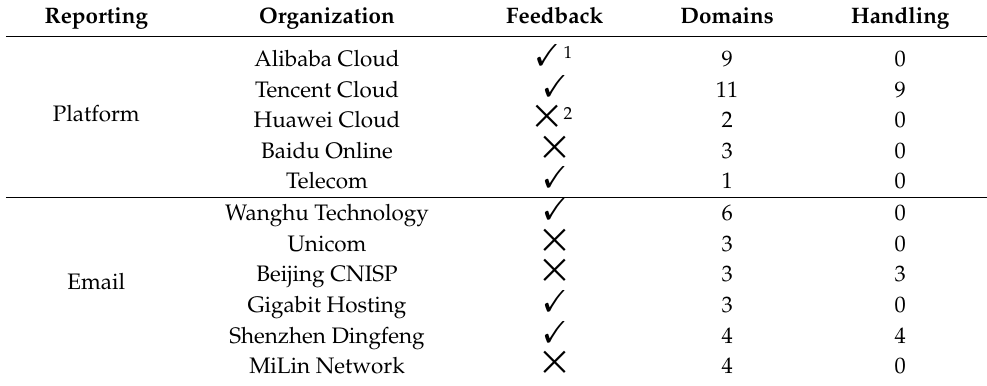
Table 7. Overview of web hosting providers and handling results of handling abusive